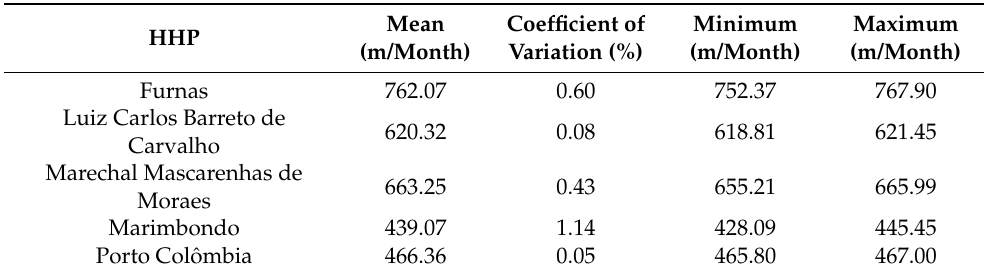
Table 5. General statistics of the levels of the reservoirs of Furnas, Luiz Carlos Barreto de Carvalho, Marechal Mascarenhas de Moraes, Marimbondo and Porto Colombia.